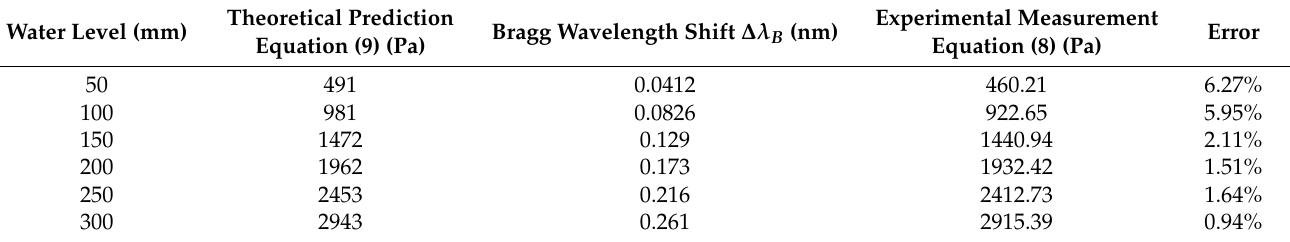
Figure 11. Bragg wavelength shift from the FBG sensor under various water levels with diaphragm thickness of 1.0 mm. Table 2. Experimental measurement and theoretical prediction of hydrostatic pressure under various water levels with diaphragm thickness of 0.7 mm.